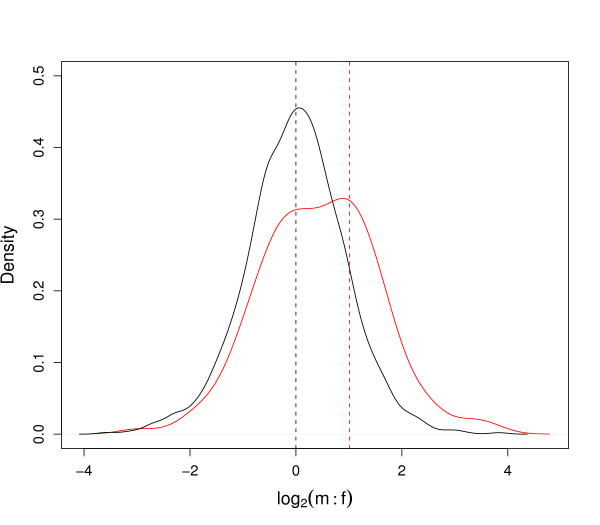
Male-to-female ratio of gene expression for autosomal and Z-linked genes. Best Gaussian kernel density function for log2(m:f) ratios of 3300 autosomal genes (black) and 156 Z-linked genes (red). A mean logarithmic male-to-female ratio (log2(m:f) of zero indicates that autosomal genes are equally expressed between females and males (black dotted line). Expression of Z-linked genes, on the contrary, is on average male biased (red dotted line) and indicates a lack of dosage compensation for most genes. The shape of the kernel is robust to different smoothing kernels and parameter settings.